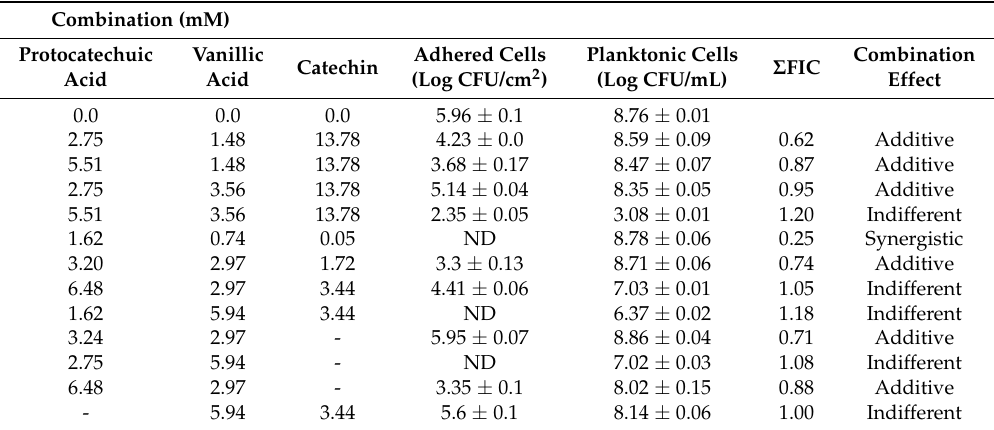
Figure 2. Effect of ( A ) protocatechuic acid, ( B ) vanillic acid, ( C ) catechin, and ( D ) nitrofurantoin on uropathogenic E. coli cell density in biofilms adhered to catheters (Log CFU/cm 2 ) and planktonic cells (Log CFU/mL) for 24 h at 37 °C. Different letters indicate significant differences among concentrations of phenolic compounds at the same cellular level ( p ≤ 0.05). The initial inoculum added to the system was 3 Log CFU/mL. Means for three independent experiments ± deviation standard are illustrated. * Mean values below the limit of detection. Table 3. Effect of combined phenolic compounds on counts of adhered uropathogenic E. coli cells on silicone surfaces and planktonic cells (24 h at 37 °C).